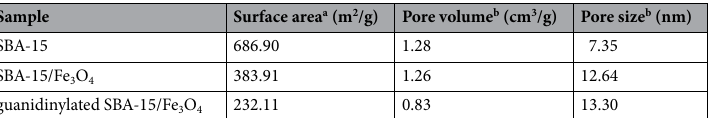
Table 1. Surface area, pore volume and pore diameter of SBA-15/Fe 3 O 4 and guanidinylated SBA-15/Fe 3 O 4 nanocomposite. a The surface area obtained by BET analysis. b Pore volume and pore diameter obtained by BJH analysis.